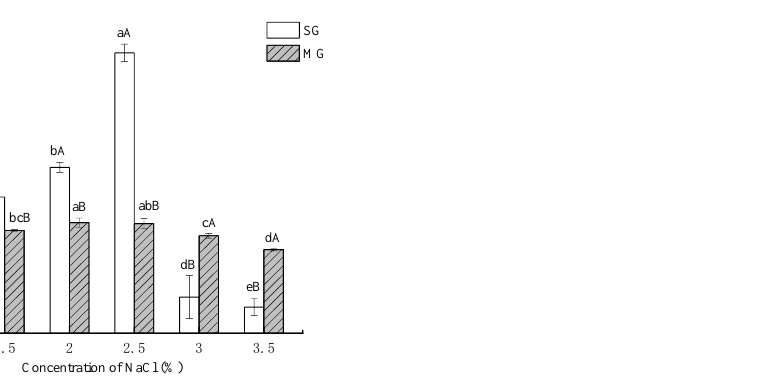
Figure 5. Effects of different NaCl concentrations on the degree of phosphorylation of SG and MG. Different lowercase letters show significant differences between the groups with different NaCl concentrations ( p < 0.05). Different capital letters show significant differences ( p < 0.05) between SG and MG.